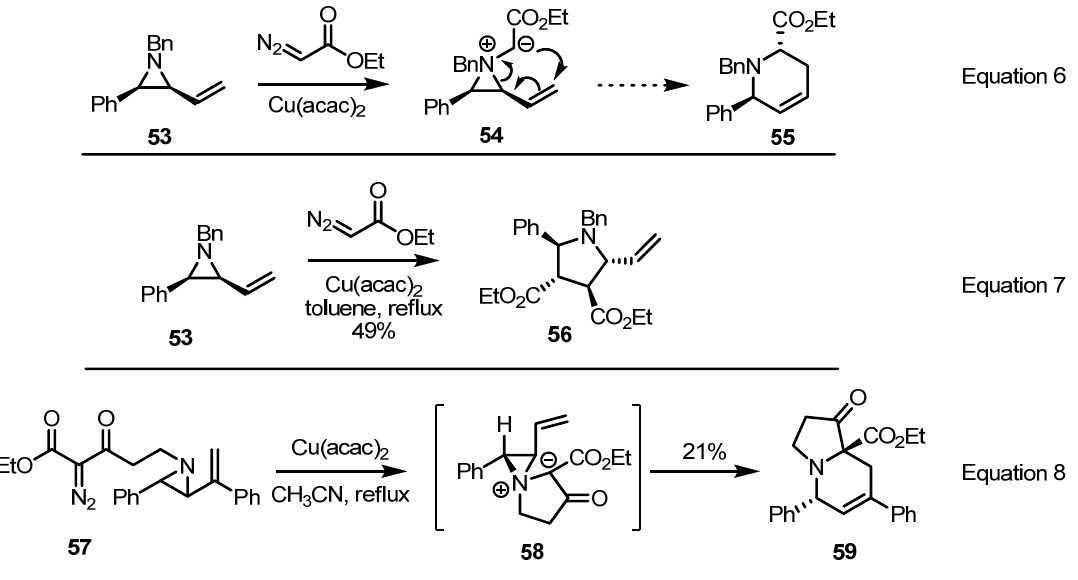
Scheme 18. [3,3]-Sigmatropic rearrangement of vinylaziridines.